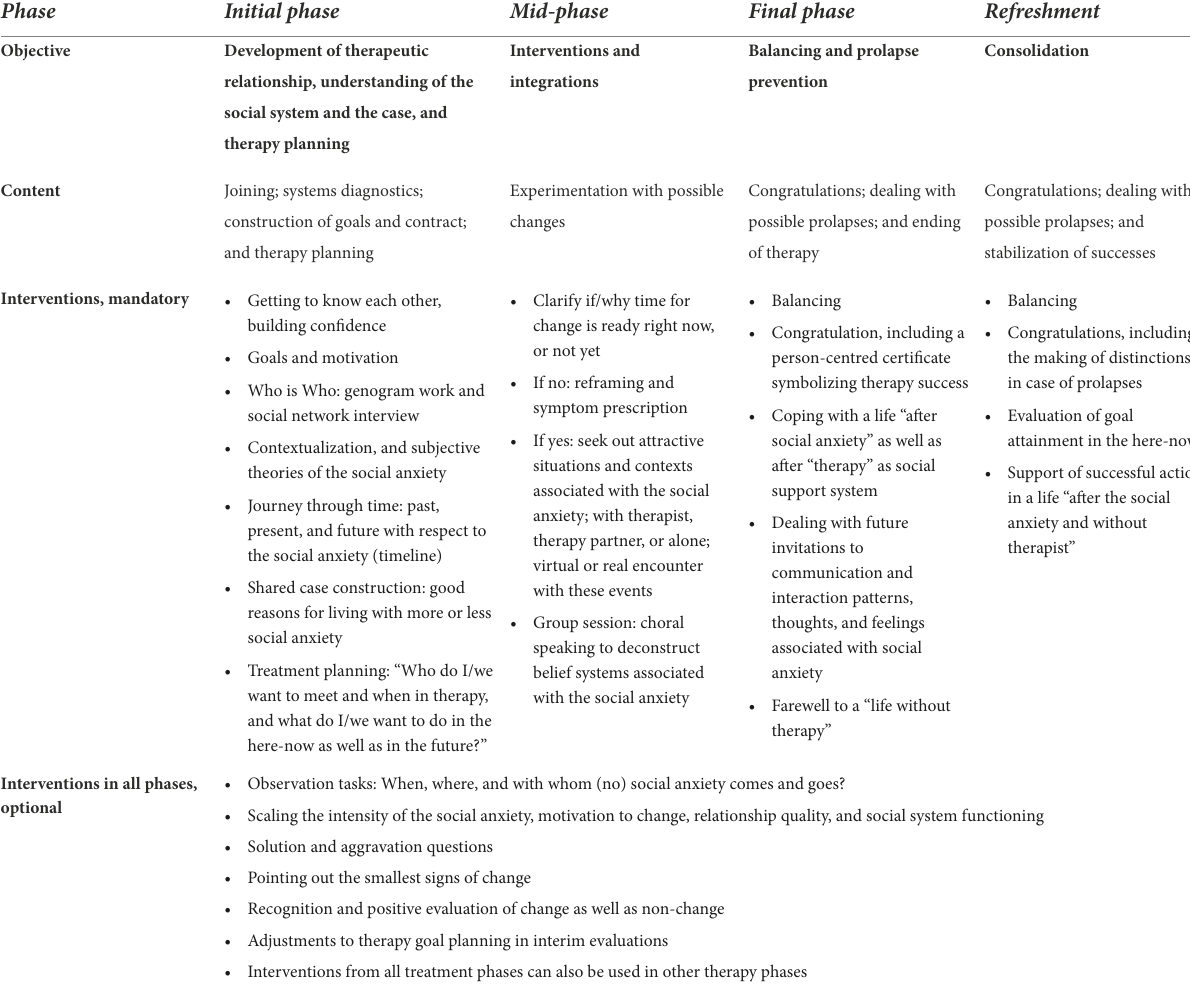
TABLE 2 Objectives depending on the therapy phase, with mandatory as well as optional interventions (Schweitzer et al.,